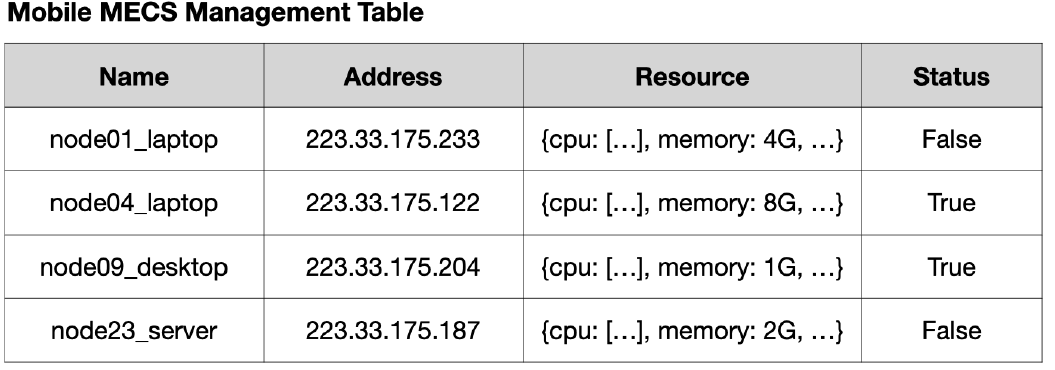
Figure 5. An example of mMT generated by the access Multi-Access Edge Computing Server